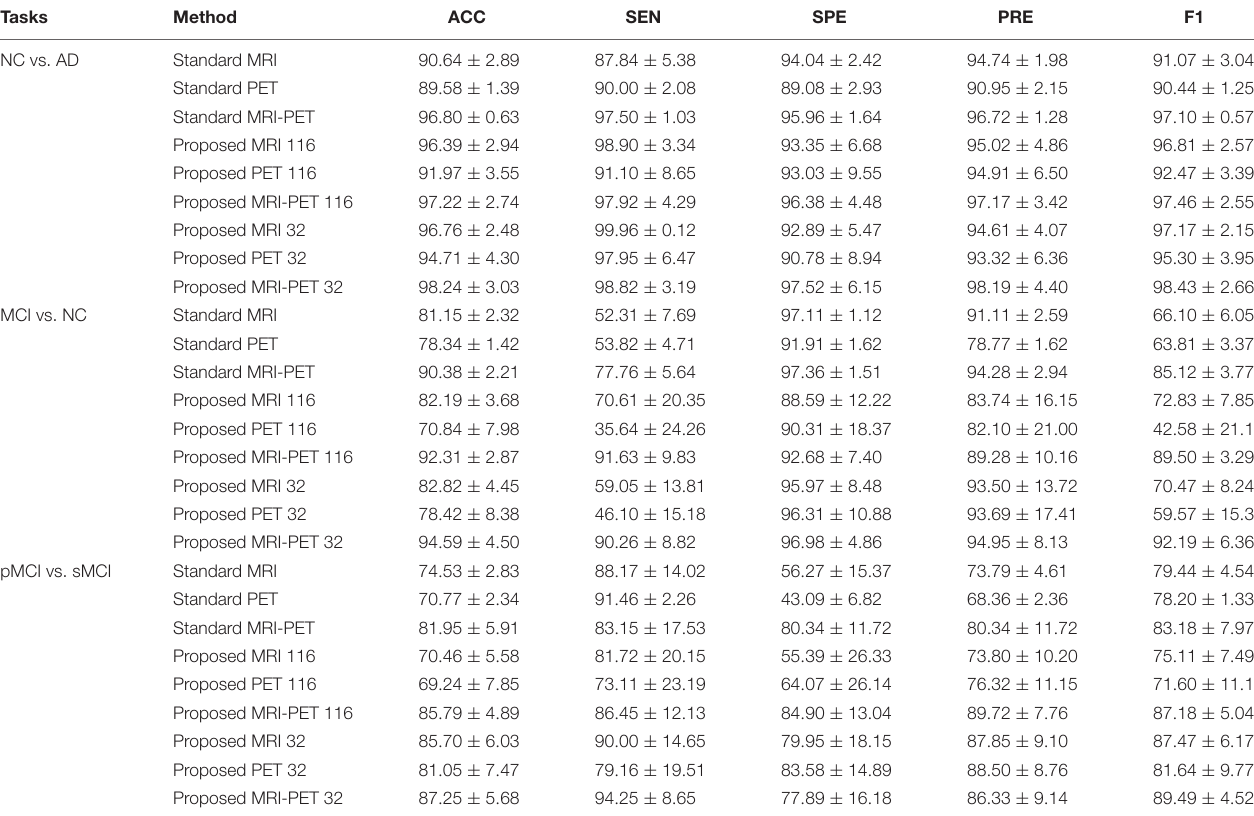
TABLE 3 | Classification comparison between the standard and the proposed method in three different binary disease classification tasks (%). Tasks Method ACC SEN SPE PRE F1 NC vs.